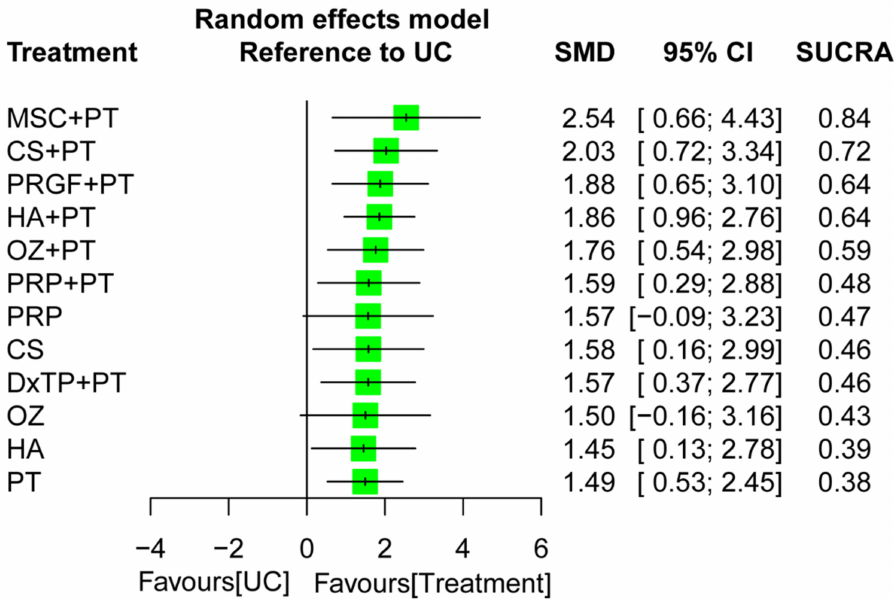
Figure 5. Forest plot summarizing the effects of treatment regimens on walking capability recovery for the entire follow-up duration. SMD, standardized mean difference; CI, confidence interval; SUCRA, surface under the cumulative ranking curve; CS, corticosteroid; DxTP, dextrose prolotherapy; HA, hyaluronic acid; MSC, mesenchymal stem cell; OZ, ozone; PRP, platelet-rich plasma; PRGF, plasma rich in growth factor; PT, physical therapy; UC, usual care.